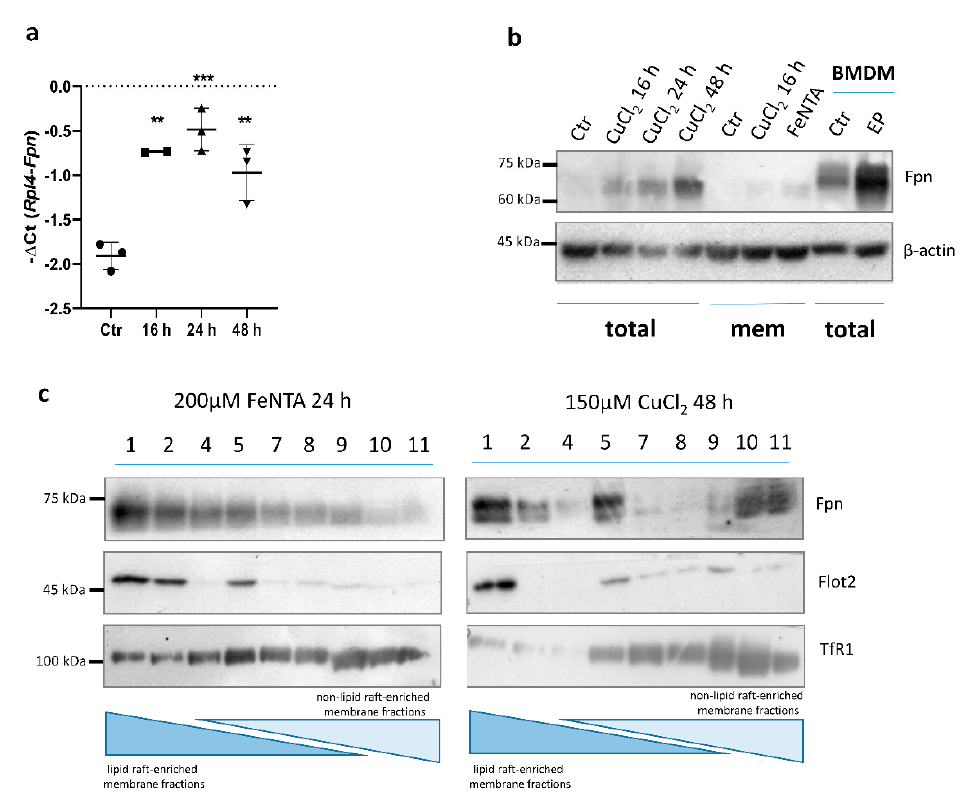
Figure 7. Copper loading increases Fpn mRNA level. ( a ) qPCR analysis of Fpn expression in RAW 264.7 cells incubated with 150 μ M CuCl 2 for 16, 24, and 48 h. Data represent mean ± SD, ** p < 0.01, *** p < 0.001. ( b ) Western blot analysis of Fpn protein level in total extract and membrane fraction of control and 150 μ M CuCl 2 -treated RAW 264.7 cells. Extract derived from BMDMs after 6 h of erythrophagocytosis (EP) was used as positive. ( c ) Western blot detection of Fpn and flotilin 2 (Flot2; raft marker) in lipid raft and non-raft-enriched (TfR1) membrane fractions of Fe-NTA (200 μ M) and CuCl 2 (150 μ M) treated RAW 264.7 macrophages. Numbers indicate subsequent fractions collected after discontinuous iodixanol density gradient ultracentrifugation.